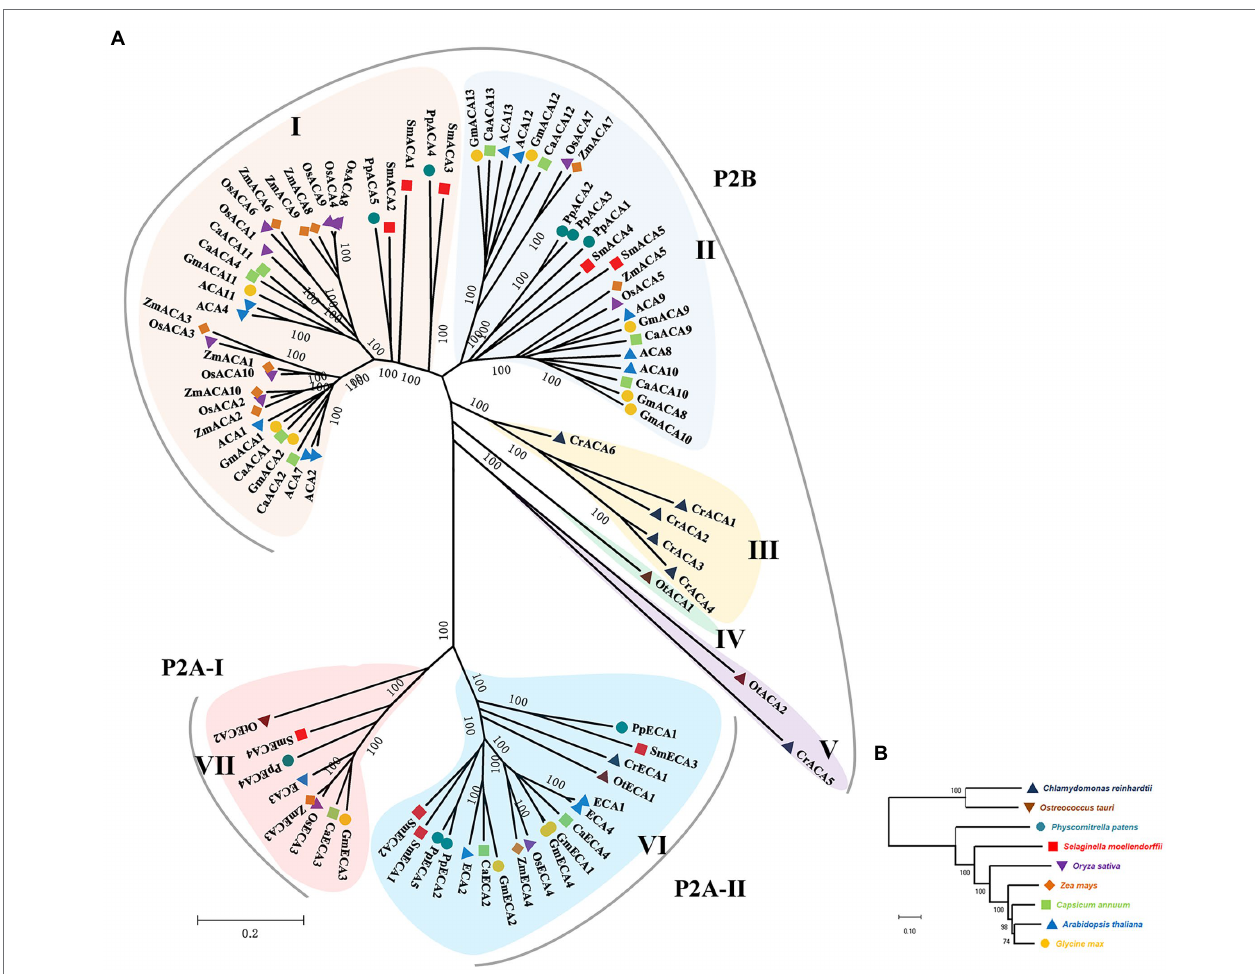
FIGURE 1 | The phylogenetic tree for the P 2 - type ATPases. (A) The tree was constructed from a complete alignment of Chlamydomonas reinhardtii , Ostreococcus tauri , Physcomitrella patens , Selaginella moellendorffii , Oryza sativa , Zea mays , Capsicum annuum , Arabidopsis thaliana , and Glycine max P 2 -type ATPases and generated with the MEGA-X program using the Neighbor-Joining method. The resulting groups are shown in different shades of colors. (B) Evolutionary relationship of P 2 -type ATPases between green species used to construct phylogenetic